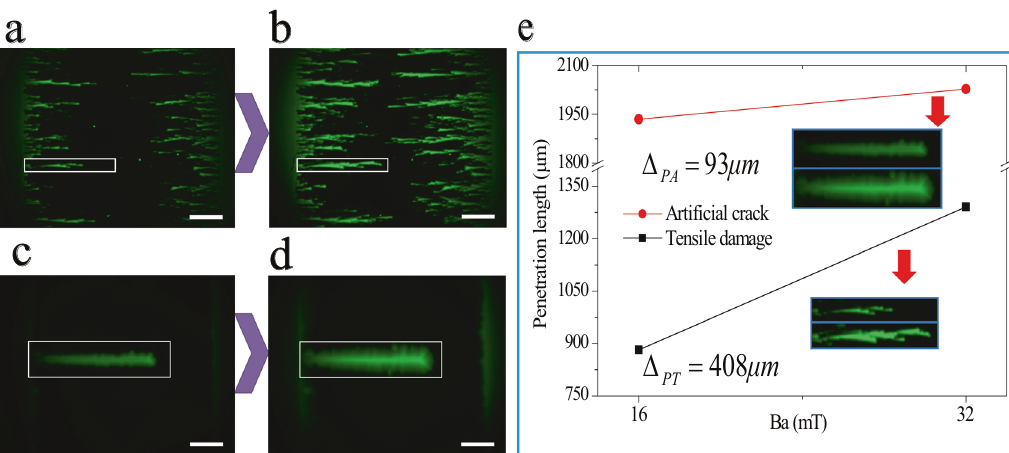
Fig. 8 A comparison of magnetic fi eld responses between samples with tensile damage and an arti fi cial crack. Here, the scale bar represents 500 μ m. a , b Flux images of the strained sample (0.76%) under zero- fi eld-cooled (ZFC) conditions 16 mT and 32 mT at 40 K, respectively. c , d Represent fl ux images of the sample with an arti fi cial crack of length 1746 μ m under ZFC conditions 16 mT and 32 mT at 40 K, respectively. e The max penetration length varies with the applied fi eld in both samples. The inset images are the regions of interest in our